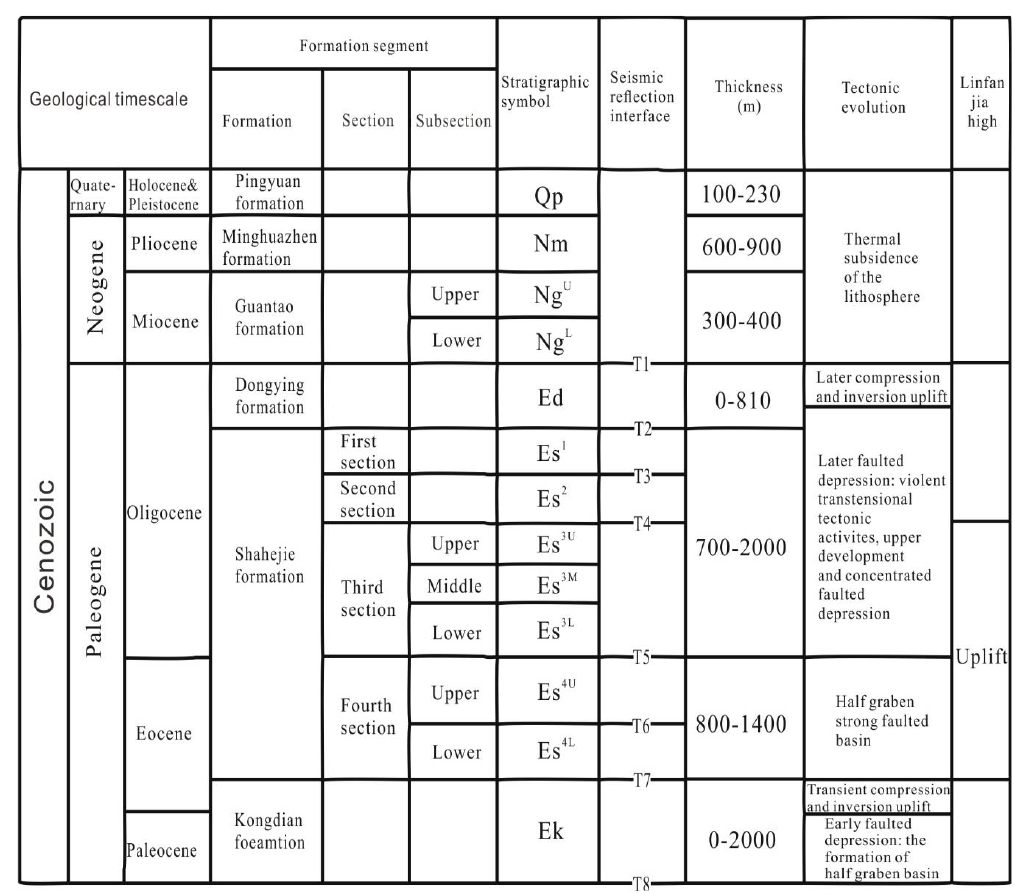
Figure 3. Stratigraphic sequence and structural events in the Huimin depression. Diagram was revised from Feng (2017) [25].